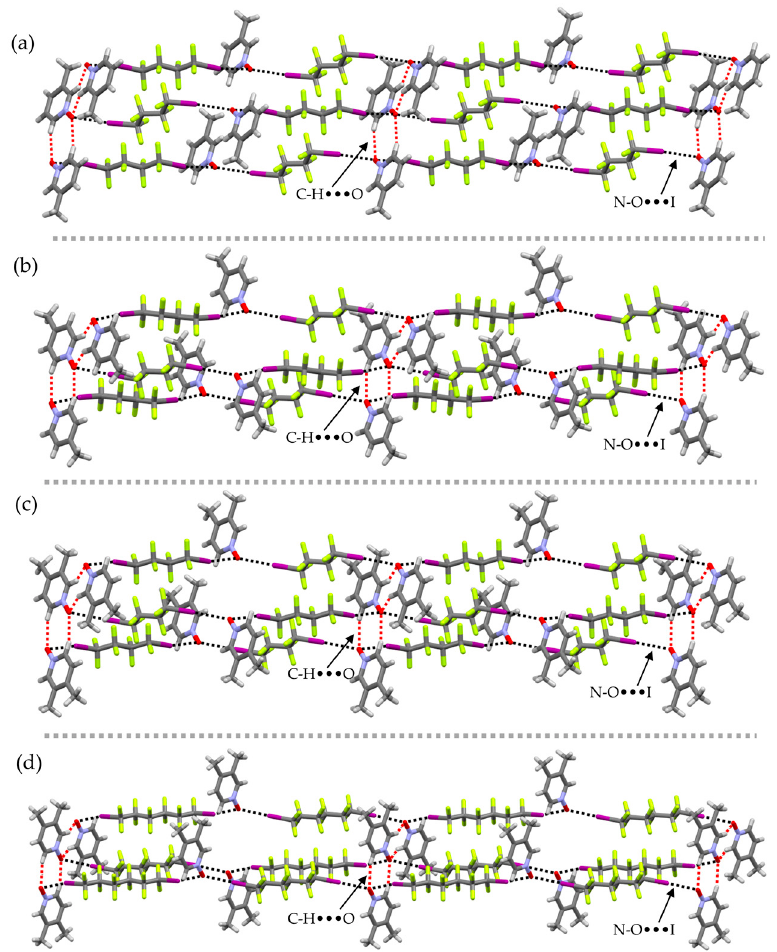
Figure 3. 1-D Halogen bond polymers stitched by adjacent ortho- C − H···O interactions in, 3•DI4 ( a ), 4•DI4_I ( b ), 7•DI4 ( c ) and 7•DI6 ( d ) shown in capped stick models. Black and red broken lines are respectively XB and HB interactions.